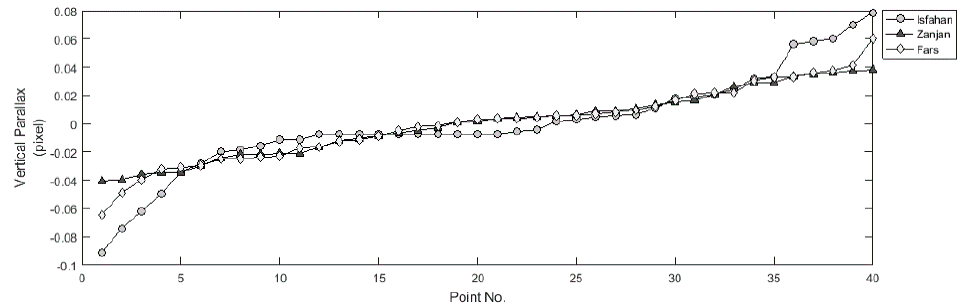
Figure 8. Vertical parallax of CIPs on the normalized scenes in Experiments 2, 6, and 10.